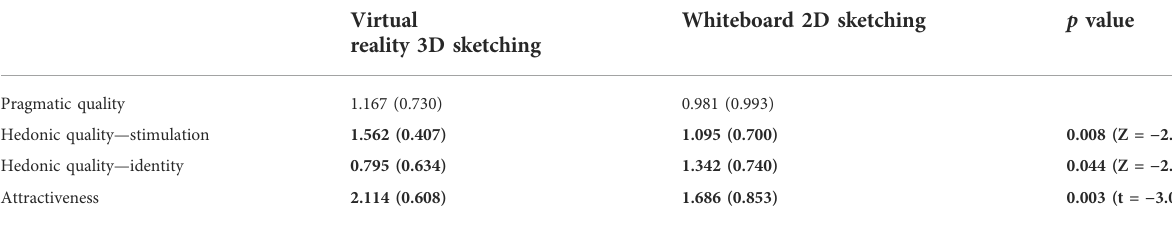
TABLE 2 Means and standard deviations (between brackets) for the four dimensions of user experience (AttrakDiff) concerning the two conditions.